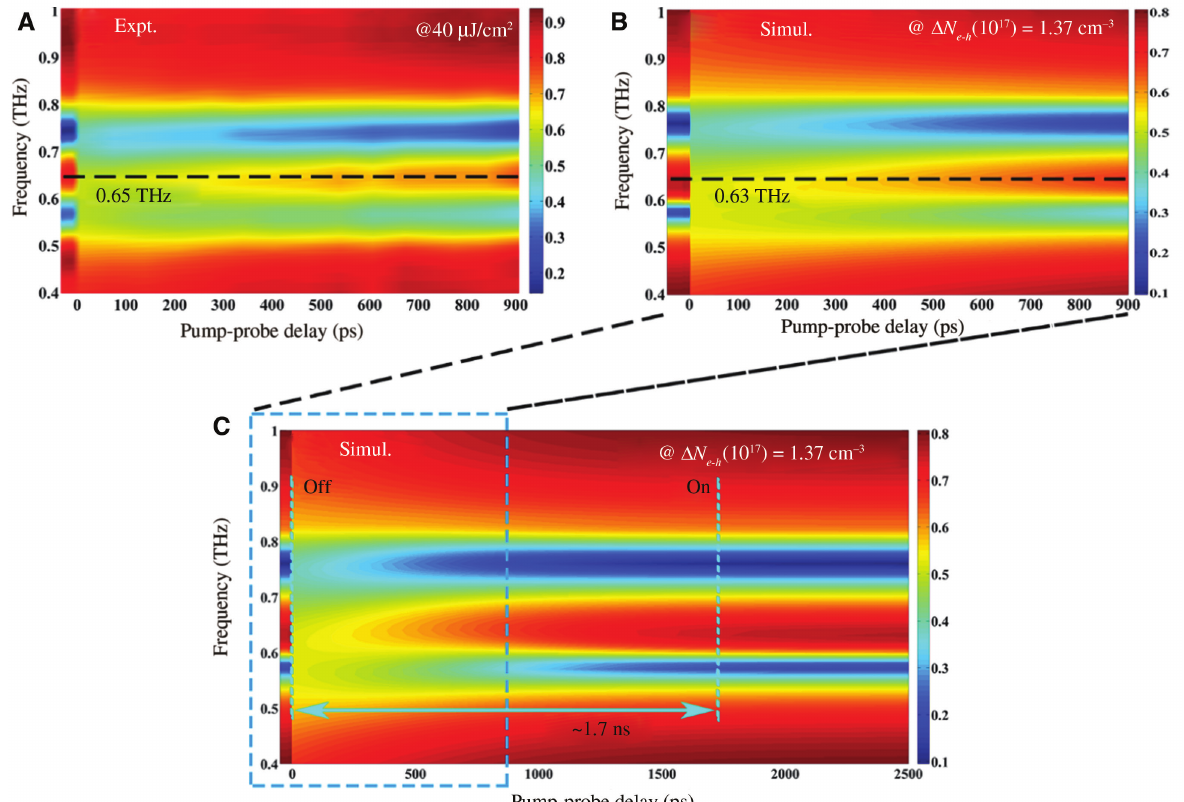
Figure 6: Transient evolution process of the slow switching changes in EIT resonance with the Si film is activated. (A) Experimental transmission spectra map of the hybrid photonic device vs. the pump-probe time delay. The pump fluence is 40 μ J/cm 2 . (B) Simulation results of the first 900 ns of the transmission spectra map. (C) Simulation results of the entire photo-switching cycle of the active EIT resonance device in slow recovery speed. The recombination rate equation of the nonequilibrium carriers (∆ N